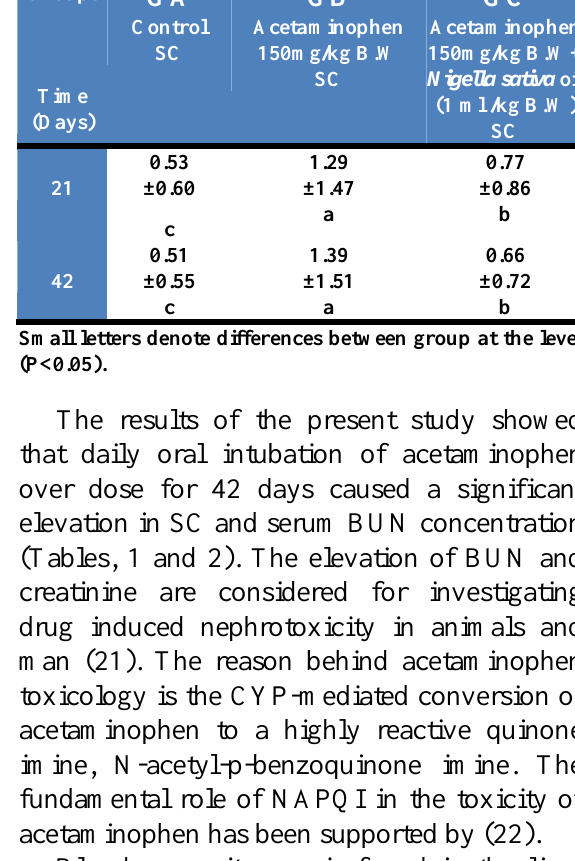
Table, 2: Serum creatinine mg/dl concentration in male rats orally administered by acetaminophen and Nigella sativa oil compared with control group.